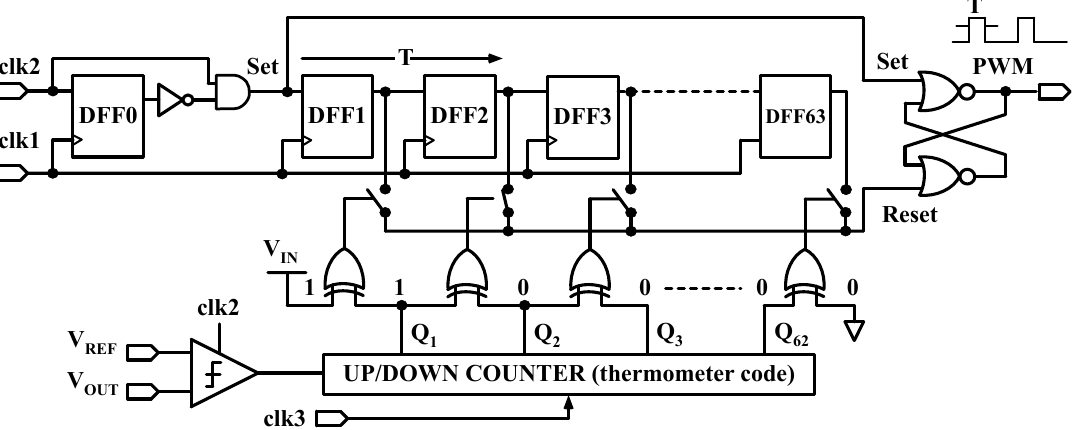
Figure 4. Block diagram of the conventional